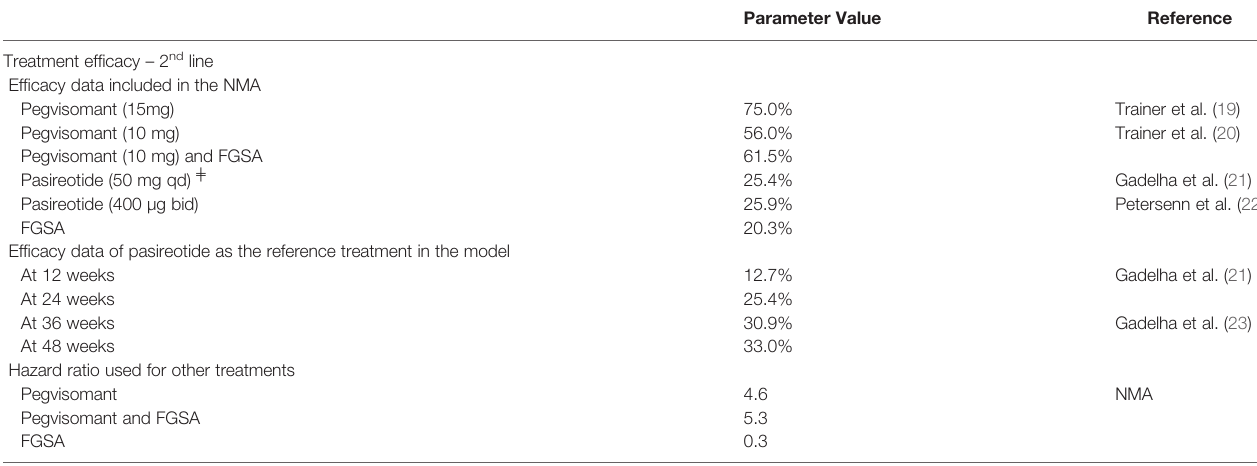
TABLE 1 | Treatment ef fi cacy data and NMA results.